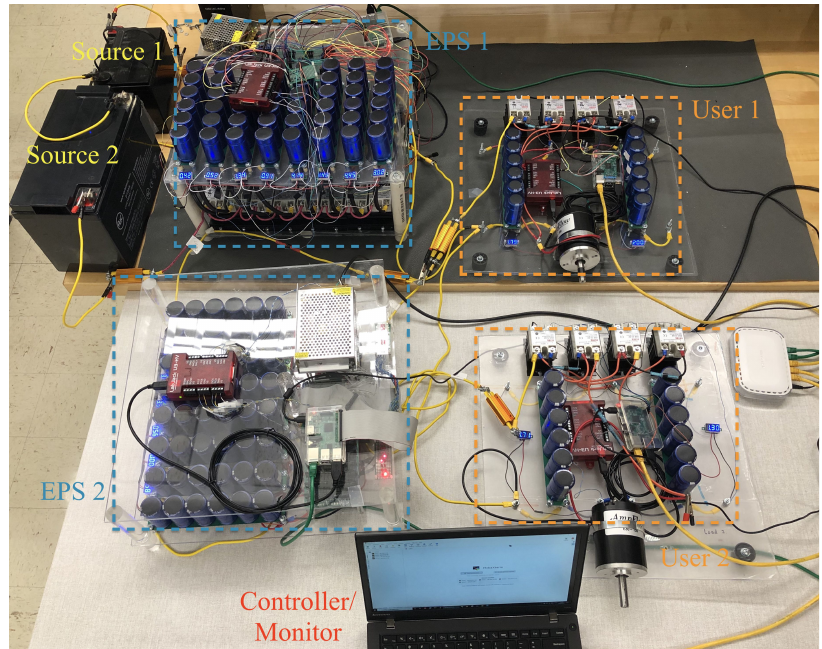
Figure 10. Photograph of an actual DMG testbed with two EPSs, two energy sources, and two loads.